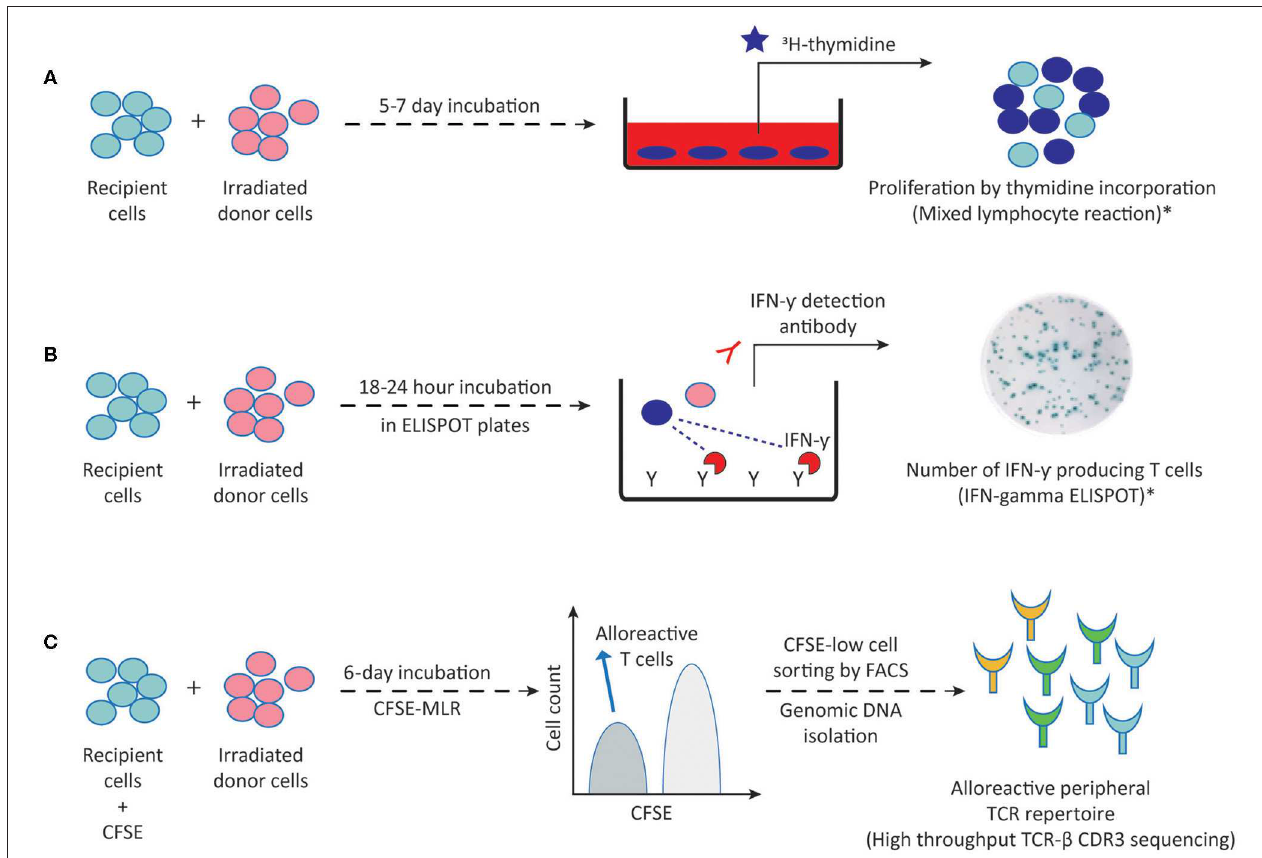
FIGURE 2 | Methods to detect alloreactive T cells. (A) Proliferation of direct pathway alloreactive T cells following 5–7 days incubation of recipient cells (responder) with irradiated donor cells (stimulator) can be measured by 3 H-thymidine incorporation into proliferating cells in MLR. (B) Following a 18–24h MLR in ELISPOT plates, IFN- γ producing direct pathway primed/memory T cells can be visualized by addition of the IFN- γ detection antibody. (C) Following a 6-day MLR, CFSE-low dividing direct pathway alloreactive T cells are sorted by FACS and genomic DNA is isolated for high throughput TCR- β CDR3 sequencing. This generates an alloreactive TCR repertoire which can then be compared to the TCR repertoire of the unstimulated patient sample. 3 H-thymidine, tritiated thymidine; CFSE, carboxyfluorescein succinimidyl ester; MLR, mixed lymphocyte reaction; TCR- β , T cell receptor beta chain; FACS, fluorescence activated cell sorting; CDR3, complementarity determining region-3. Dark blue circles represent alloreactive T cells. *These methods are also being used for detecting indirect pathway alloreactive T cells by replacing irradiated donor cells with donor cell fragments, synthetic peptides or synthetic HLA